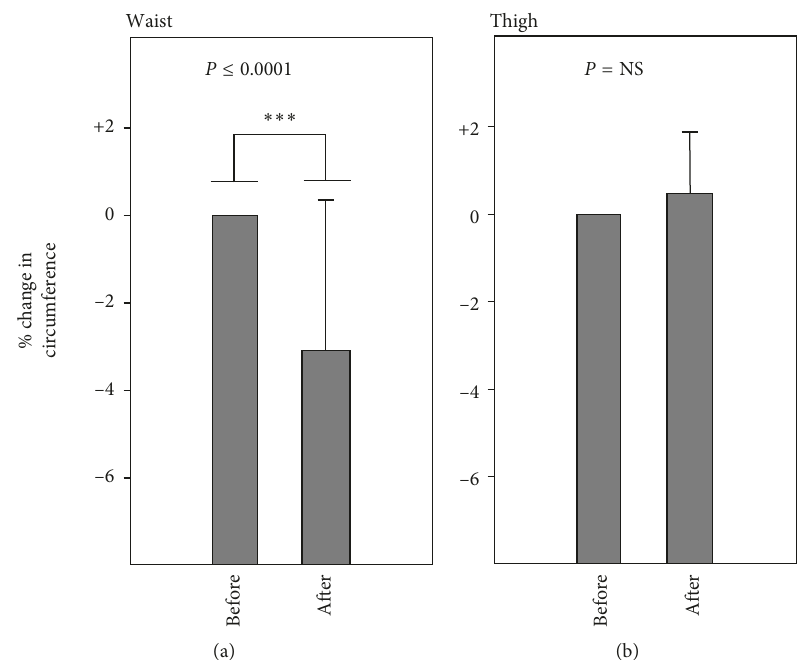
Figure 1: Timeline of the cryotherapy procedure. (a) Standard procedure in which physiological parameters (weight, BMI, fat mass, and waist and thigh circumferences) are measured (MP) before and after cryotherapy (CRYO, duration (b) and (c)). (b) Group 1 ( n 18) underwent the procedure on 3 serial days. (c) Group 2 ( n (cid:31) dual-energy X-ray absorptiometry (DXA) scanning was performed as indicated before the procedure and following three and six procedures.